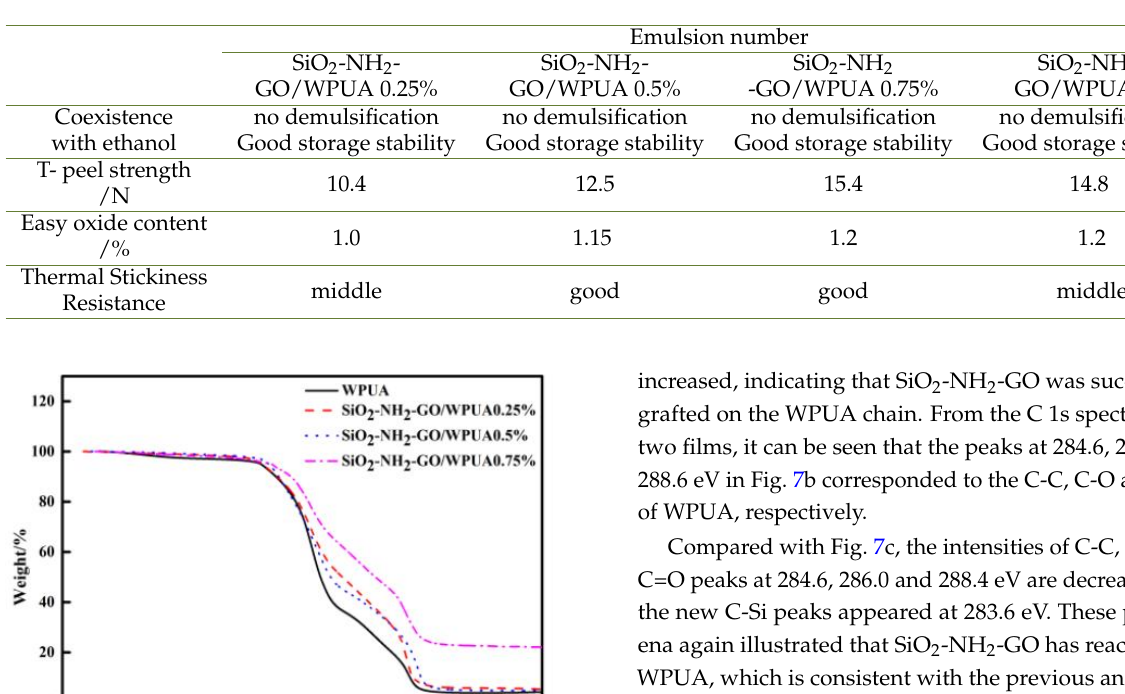
Table 3. The test results of SiO 2 -NH 2 -GO/WPUA emulsion